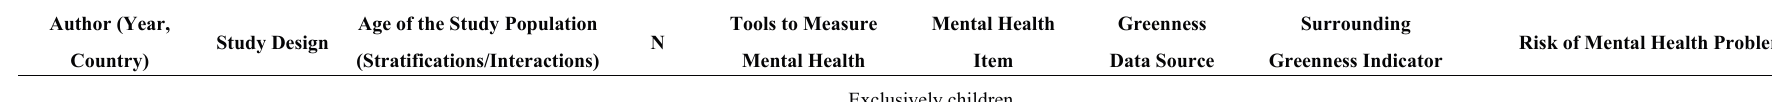
Table 1. Main characteristics and results of the studies on surrounding greenness and mental